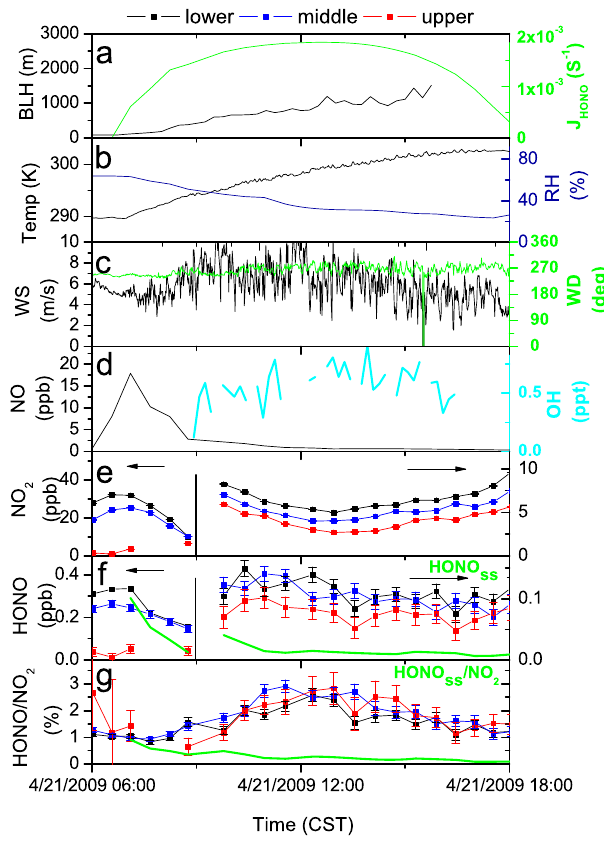
Fig. 3. Timeseries of meteorological data, J HONO , NO, OH, HONO, NO 2 and HONO to NO 2 ratio on 21 April 2009. OH data were not available on this day. OH data shown here are the av- erage of sunny days during SHARP. HONO and NO 2 data after 09:00CST are displayed with different scales on the right y-axis. Error bars of one standard deviation are shown for NO 2 , HONO and HONO/NO 2